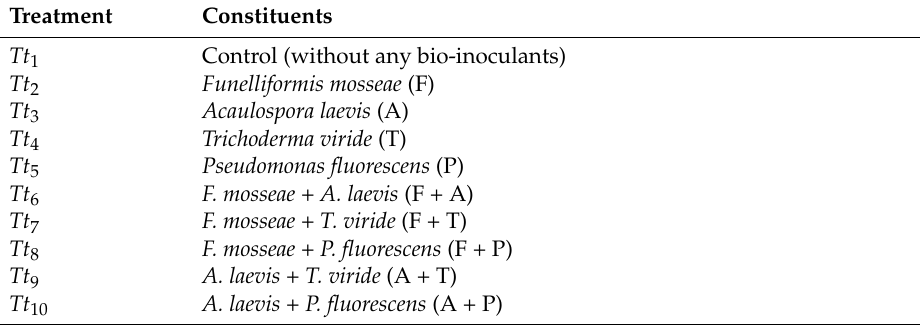
Table 1. The following sixteen treatments (Tt) were maintained for the growth